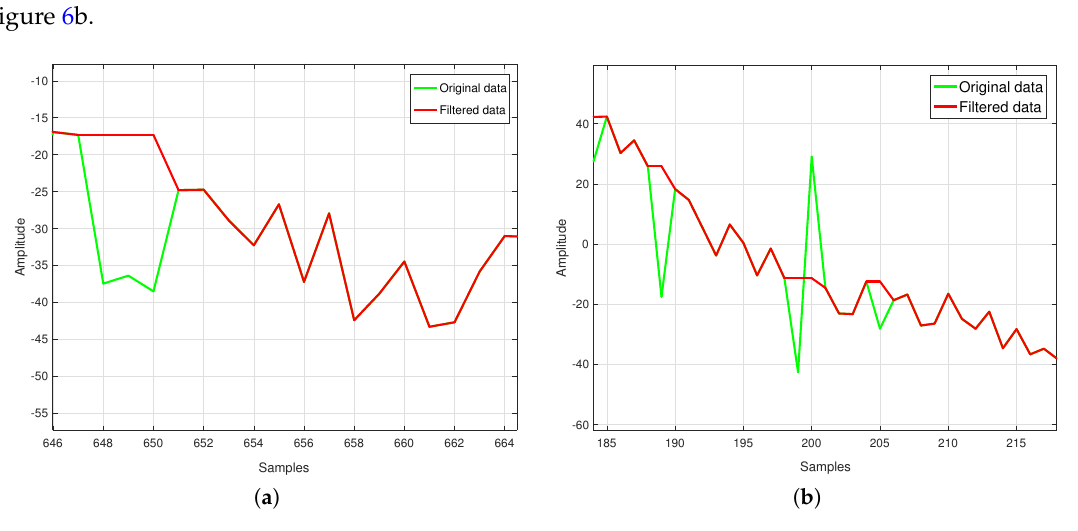
Figure 6. ( a ) multiple outliers; ( b ) inverse